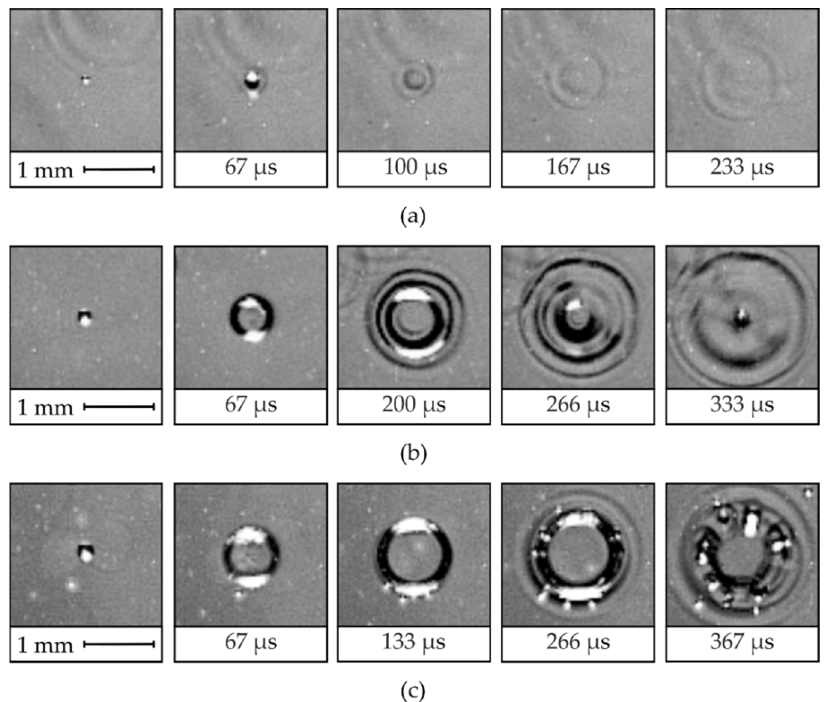
Figure 6. Various scenarios of the droplet impacts on the liquid film observed during spray cooling ( Q = 0.5 mL/s): ( a ) small-scale wave disturbance caused by small droplets; ( b ) crater formation; ( c ) splashing crown.